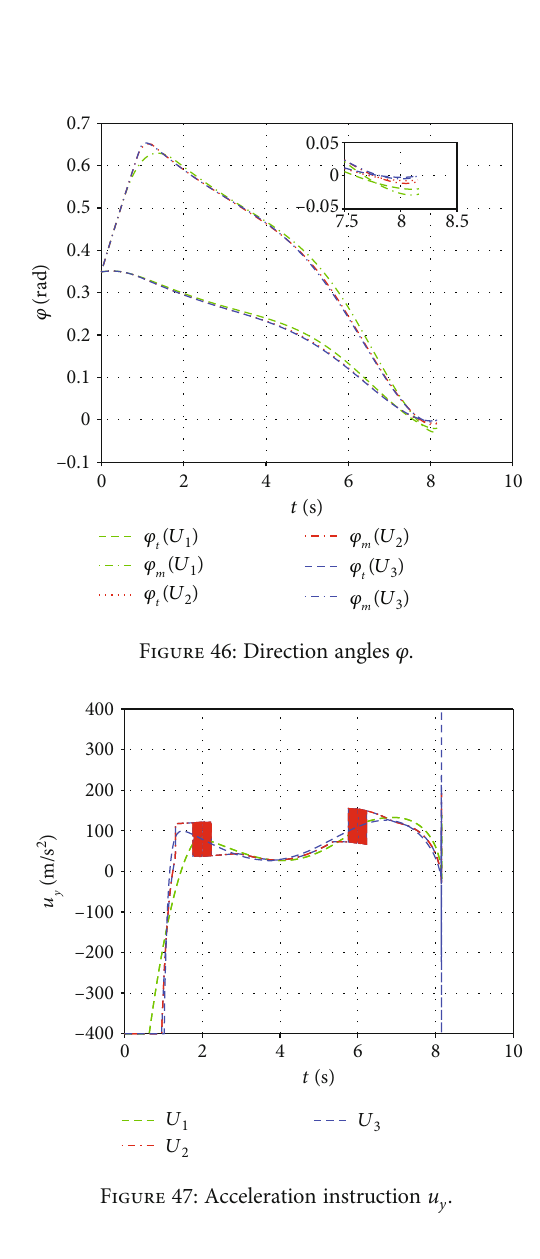
Figure 47: Acceleration instruction u